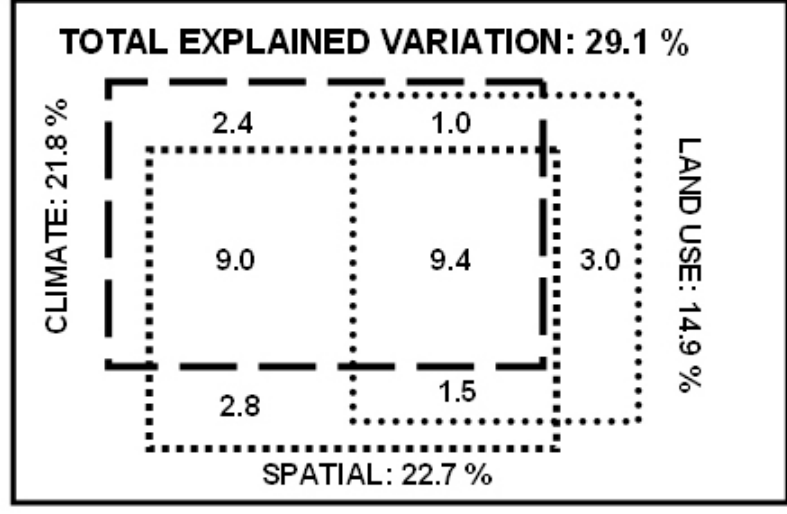
Fig. 2 . Proportion of total variance explained by different groups of environmental variables considered, as indicated by the hierarchical partitioning